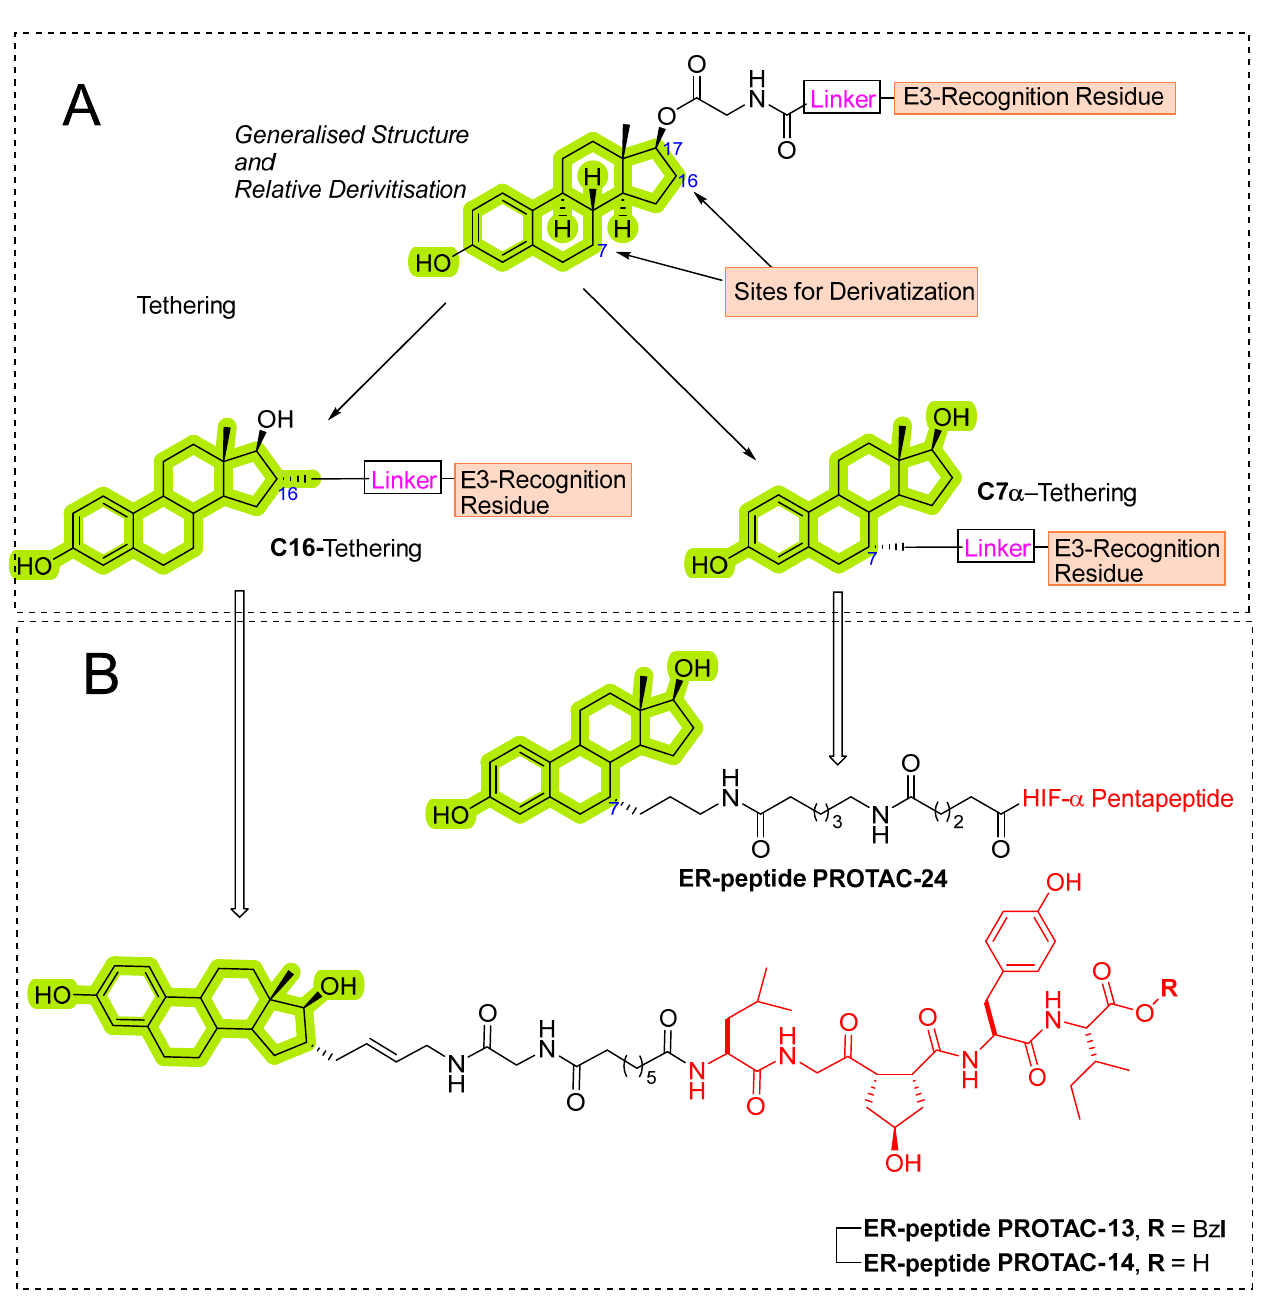
Figure 7. Development strategy for peptide-based ER-PROTACs. ( A ) Generalized structures and possible cases of derivatization. ( B ) Yielded peptide-PROTACs.